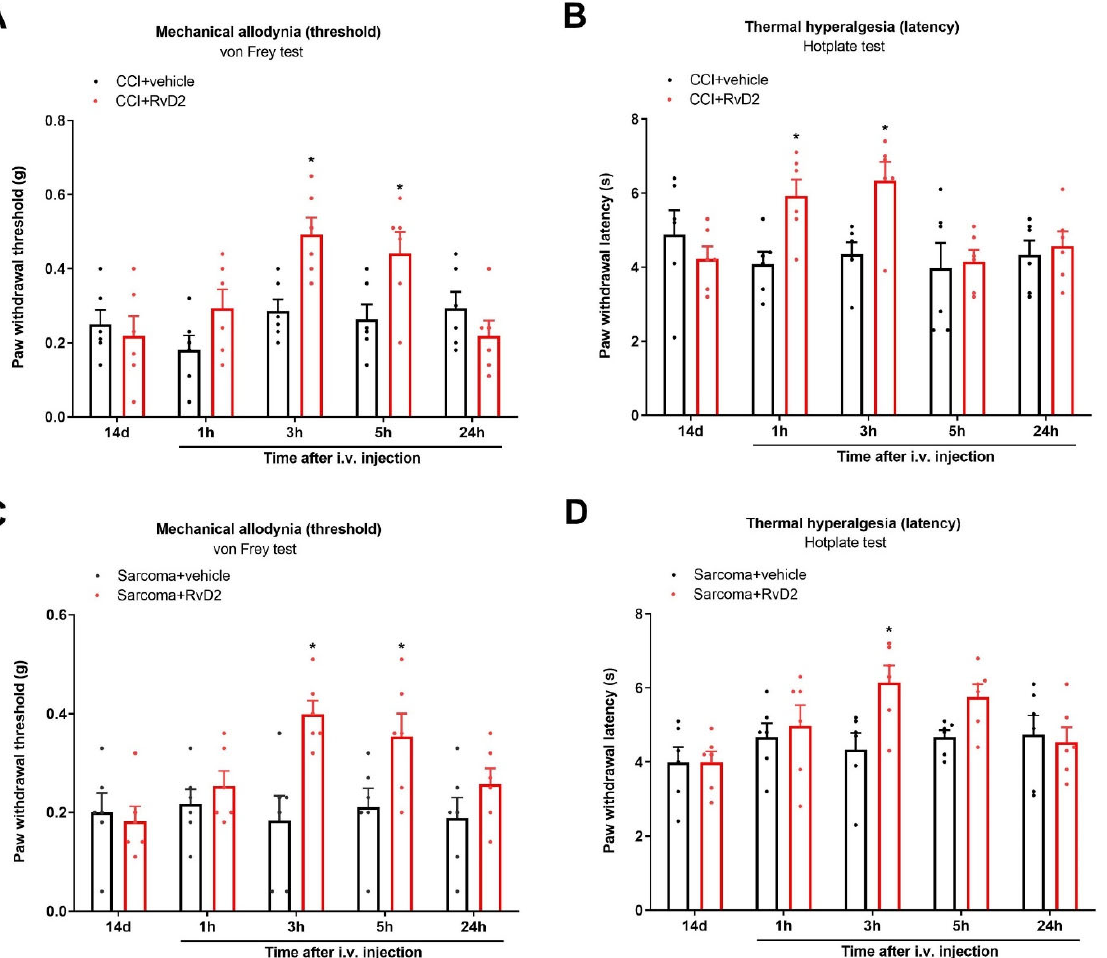
Figure 8. Systemic therapy of RvD2 reduced the existing chronic neuropathic pain and bone cancer pain. RvD2 (5 µ g) was intravenously (i.v.) given on day 14 following peripheral nerve trauma and sarcoma cell implantation, respectively. Mechanical allodynia was evaluated by measuring paw withdrawal threshold ( A ) using von Frey experiments, and thermal hyperalgesia was evaluated by measuring paw withdrawal latency ( B ) using hotplate experiments following CCI surgeries and RvD2 administrations. * p < 0.05 vs. group CCI + vehicle. ( C , D ) RvD2 post-treatment attenuated the established persistent bone cancer pain. * p < 0.05 vs. group sarcoma + vehicle. Results from behavioral experiments are presented as the mean ± SEM ( n = 6) and compared using two-way ANOVA followed by Bonferroni multiple comparisons.